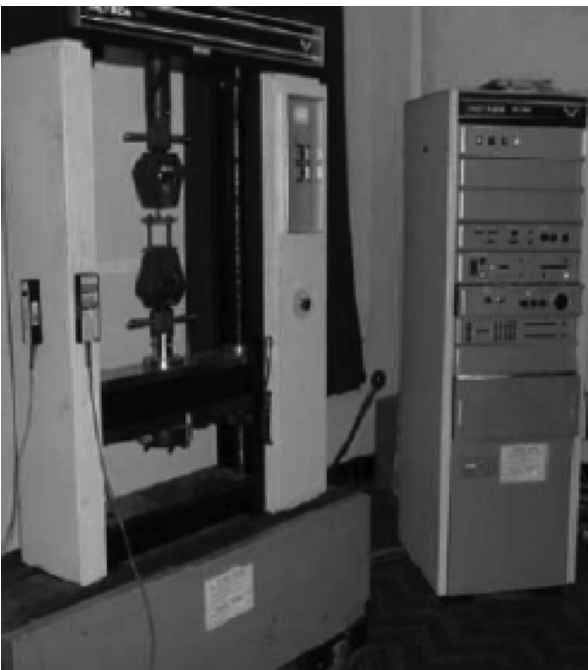
Figure 3 Surface appearance of the coir fiber before alkali